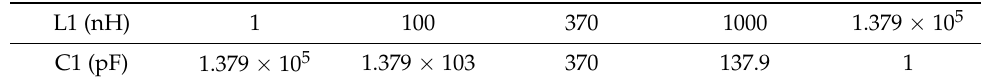
Table 2. Possible values of inductance and capacitance.